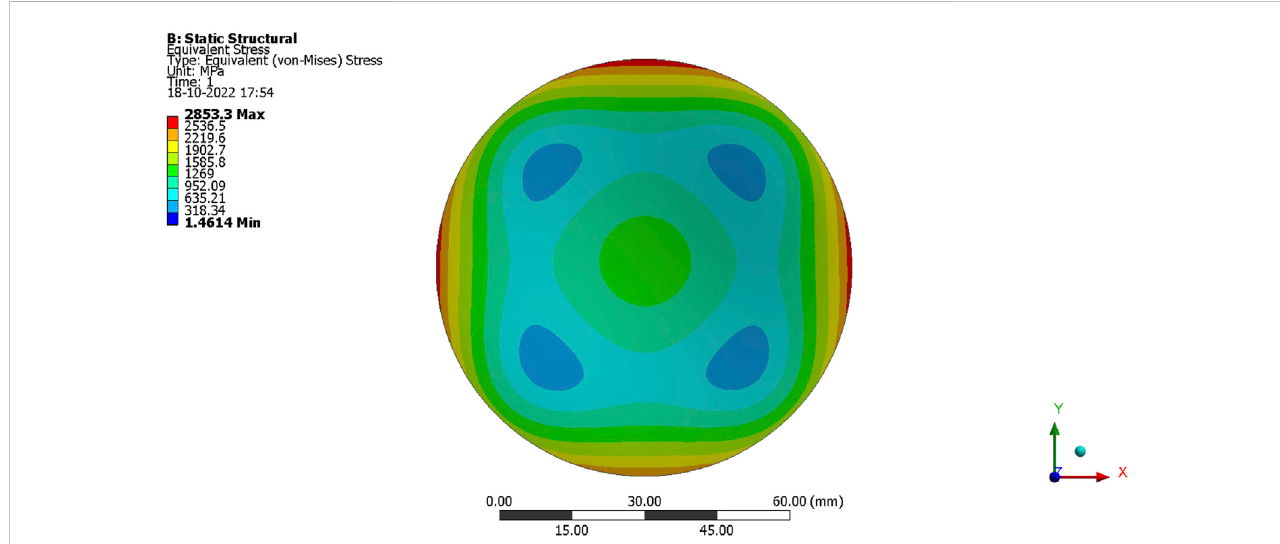
Ultimate equivalent stress of CFRP woven based test specimen.